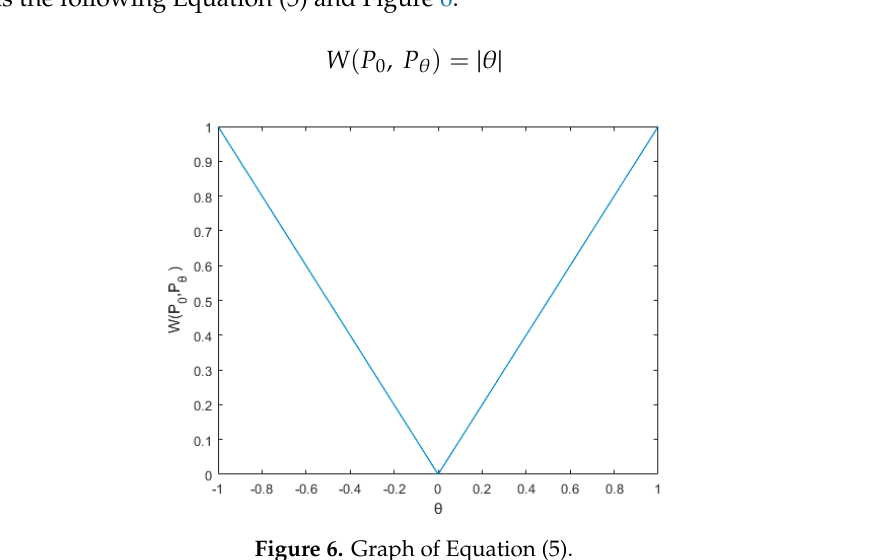
Figure 6. Graph of equation 5. Figure 6. Graph of Equation